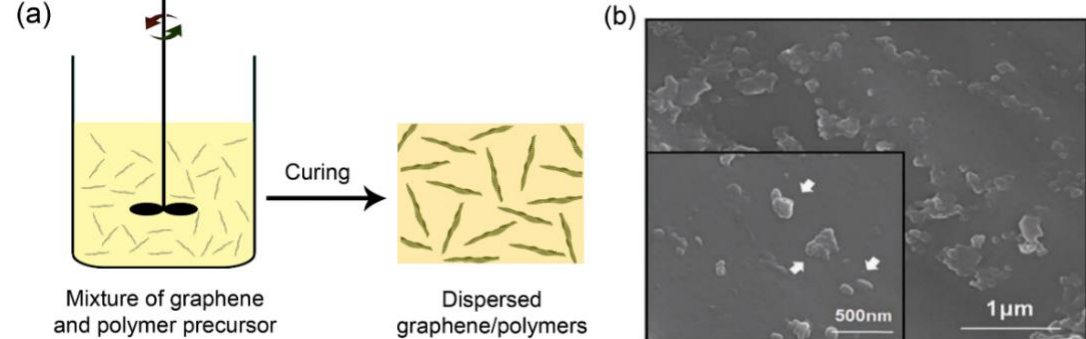
Figure 2. ( a ) Schematic illustrating the fabrication of dispersed graphene/polymers through a solution blending process. ( b ) Typical cross-sectional SEM image of the dispersed graphene/polymers (graphene loading: 10 wt %), showing the poor dispersion of graphene in the polymer matrix. Reprinted with permission from: ( b ) Reference [18], Copyright 2013, Wiley-VCH.